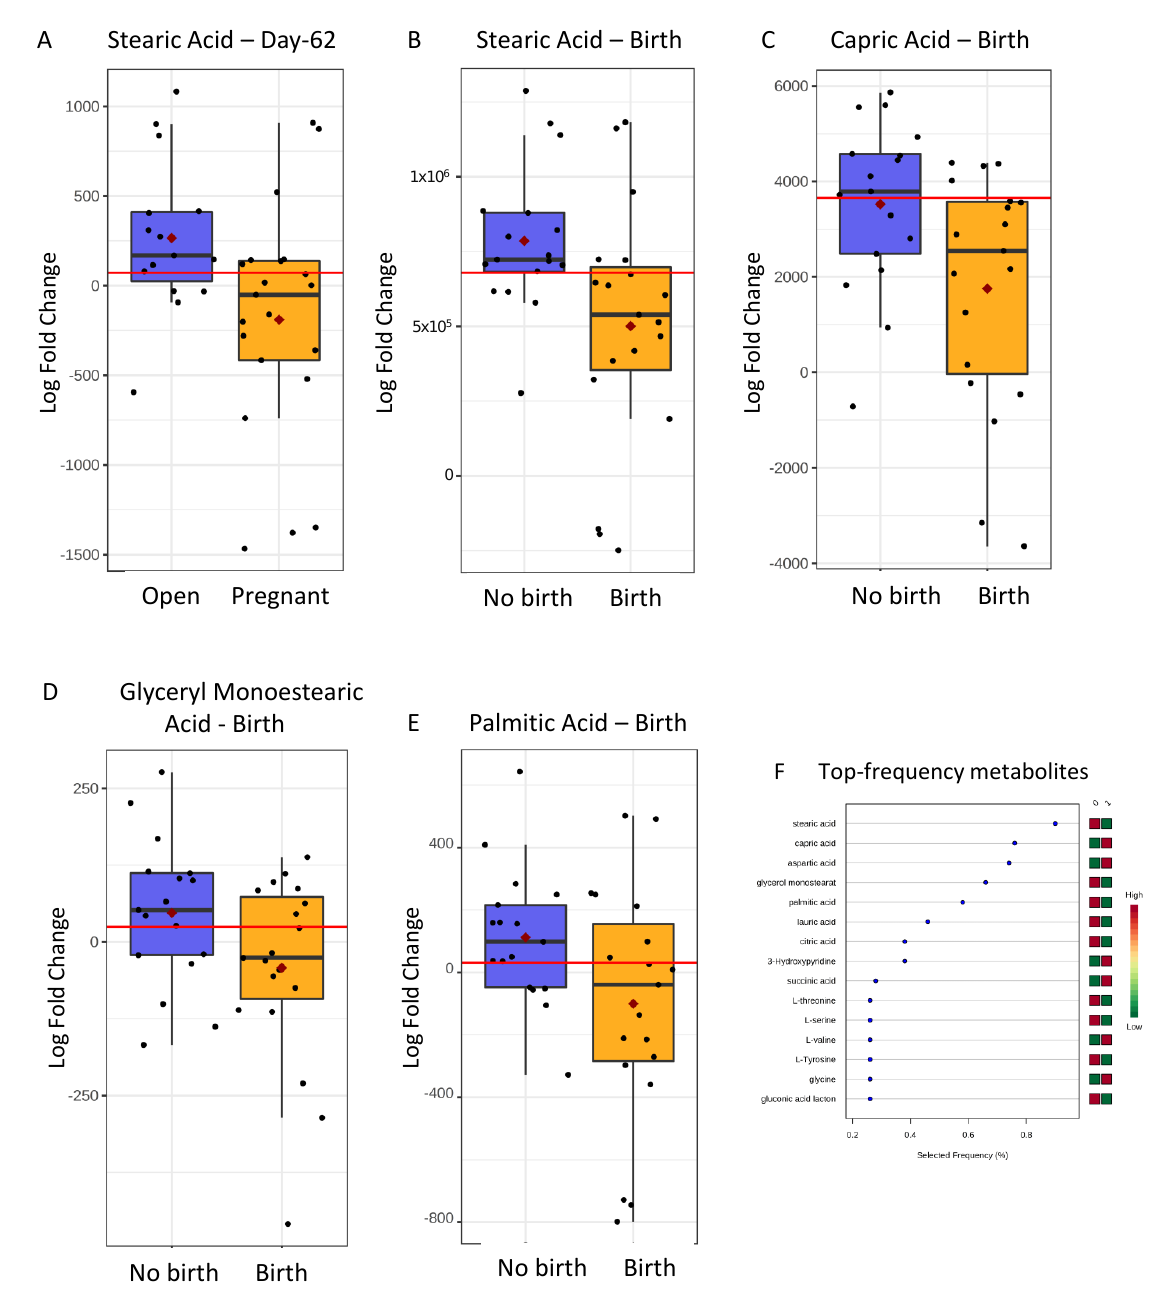
Figure 1. Boxplots of metabolite biomarkers of embryonic viability measured in embryo culture medium of embryos that led to pregnancy or non-pregnancy: Stearic Acid on pregnancy Day-62 ( A ; ROC-AUC = 0.733 [0.570–0.898]), and Stearic acid at birth ( B ; ROC-AUC = 0.743 [0.437–0.838]), Capric Acid at birth ( C ; ROC-AUC = 0.728 [0.465–0.840]), Glyceryl Monostearate at birth ( D ; ROC-AUC = 0.670 [0.570–0.898]), and Palmitic Acid at birth ( E ; ROC-AUC = 0.669 [0.533–0.870]). Black dots represent the concentrations of all samples of each metabolite scaled as Log Fold Change values. The notch indicates the 95% confidence interval around the median. The mean concentration of each group is shown by a red diamond. The optimal cut- off is indicated as a horizontal red line (i.e., the closest to the left-hand corner in the corresponding ROC-AUC). ( F ) represents the above and other top metabolites (Y axis) ranked by their contribution to classification accuracy in predicting birth expressed as frequency (X axis) (Random Forests multivariate classification